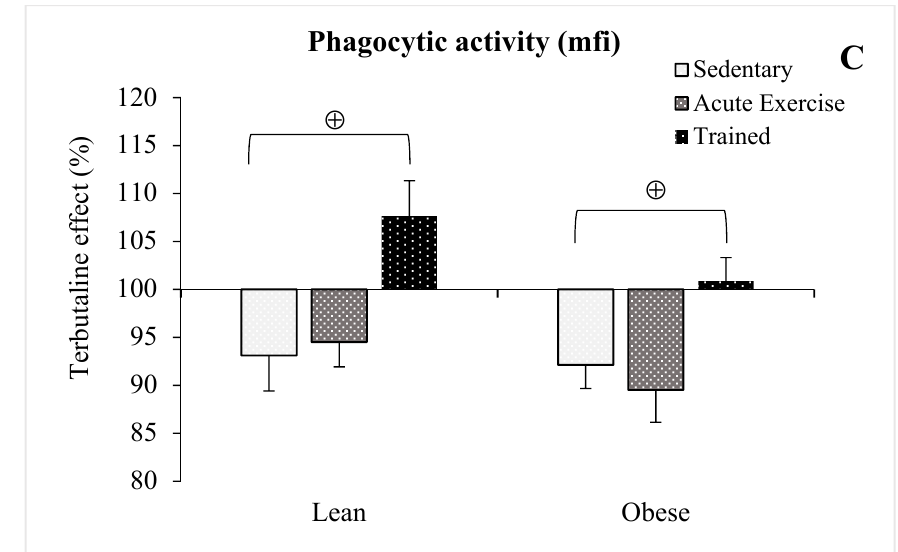
Figure 3. Effect of the β 2-adrenergic agonist terbutaline on the phagocytic activity of peritoneal macrophages from lean ( A ) and obese ( B ) mice (sedentary, acute exercise, and trained mice). Effect of terbutaline expressed as percentage change from baseline ( C ). Columns represent the mean ± SEM of independent assays performed in duplicate. * p < 0.05 with respect to the corresponding control value, in the absence of terbutaline; • p < 0.05 with respect to the sedentary control group; ⊕ p < 0.05 with respect to the corresponding sedentary group. Table 3. Effect of the β 2-adrenergic agonist terbutaline on the phagocytic percentage and microbicide percentage of peritoneal macrophages from lean and obese mice (sedentary, acute exercise, and trained mice). Sedentary Acute Exercise Trained